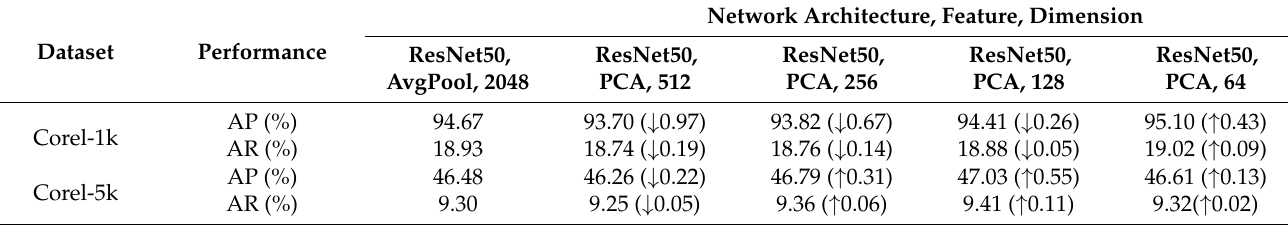
Table 8. APs and ARs results by applying PCA to deep features, Top NR =